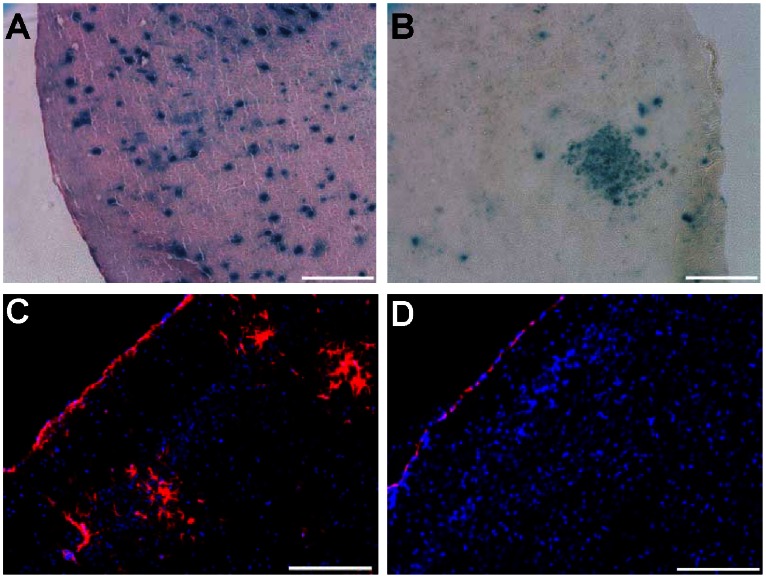

LacZ and GFAP expression in AAVrh8-CBACre injected Tsc1c/cROSA mice.
Tsc1c/cROSA mice were injected at P0 with AAVrh8-CBA-Cre vector (2×109g.c. in each ventricle), and lacZ expression in the brain was analyzed at 6 months (N = 2). (A & B) LacZ+ cells were observed scattered as single cells or in patches throughout the cortex. (C & D) Immunocytochemical staining for GFAP with DAPI dye staining of nuclei revealed numerous foci of GFAP+ (red) cells in the cortex (C) while uninjected controls were devoid of any GFAP+ cells in the cortex (D). Scale bars: A–D: 200 µm.